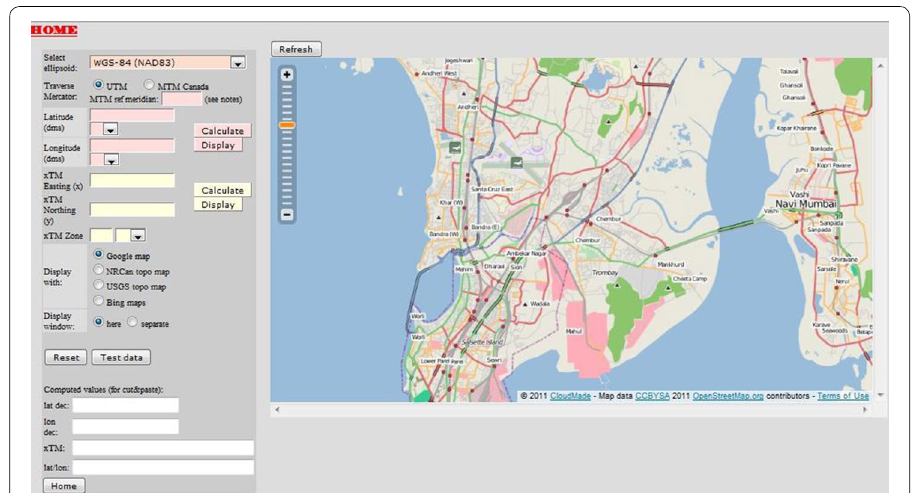
Fig. 8 Interface of Open street map (OSM) integrated into